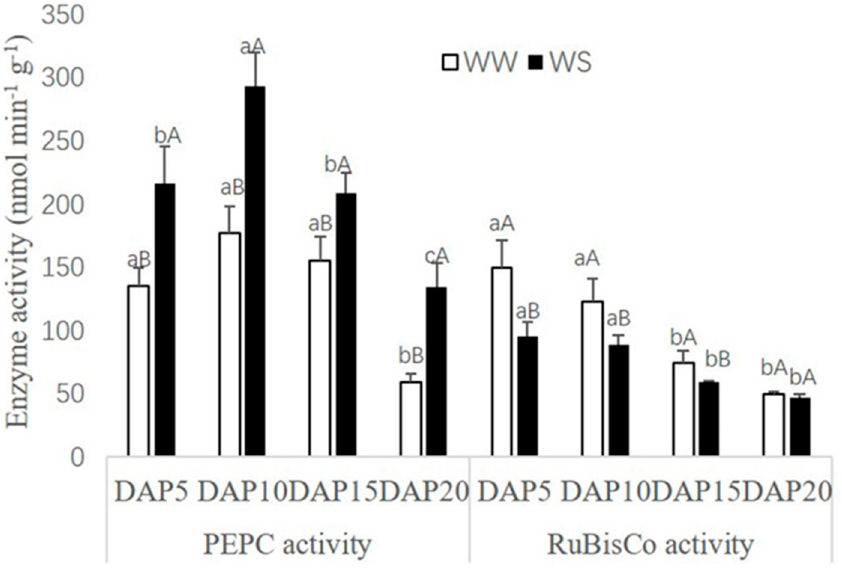
Figure 3. Effect of drought stress on photosynthetic enzyme activity (nmol min − 1 g − 1 ) in the pod wall. Different small letters up the white bar and different capitals up the black bar within one photosynthetic enzyme mean a significant difference at the 0.05 probability level. WW, well-watered; WS, water-stressed.